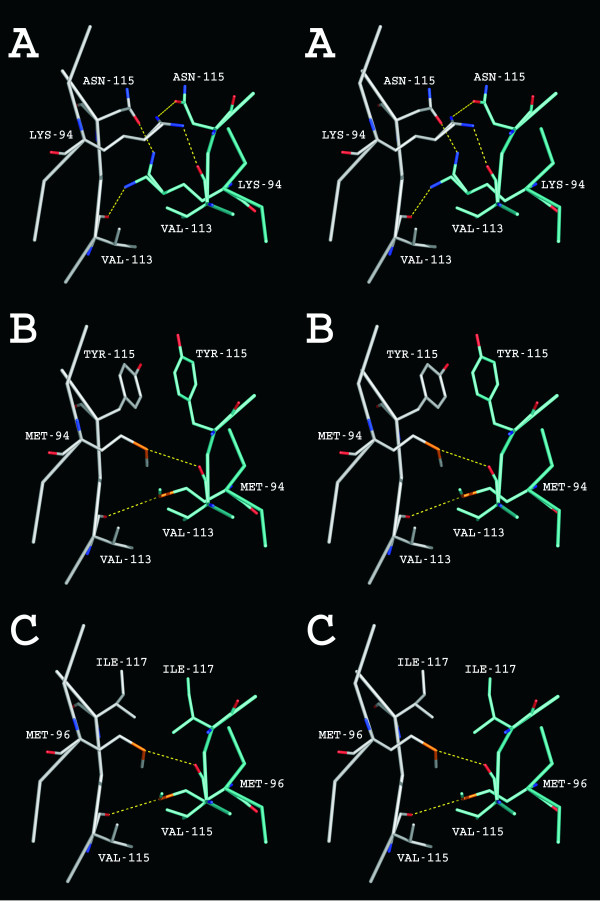
The 1–3 subunit interface of AVR2, AVR4 and avidin. Stereo images of the 1–3 subunit interface of (A) AVR2-b, (B) AVR4 [PDB:1Y52] [38], and of (C) avidin expressed in E. coli [PDB:1VYO] (Airenne, Hytönen et al. unpublished) are shown. Lys-94 of AVR2 exists in two alternate conformations, which can form a hydrogen bond with the side-chain oxygen atom of Asn-115 or with the main-chain oxygen atom of Val-113, both from an adjacent subunit. Putative hydrogen bonds are shown by dashed lines. The carbon atoms of subunits 1 and 3 are coloured white and cyan, respectively.